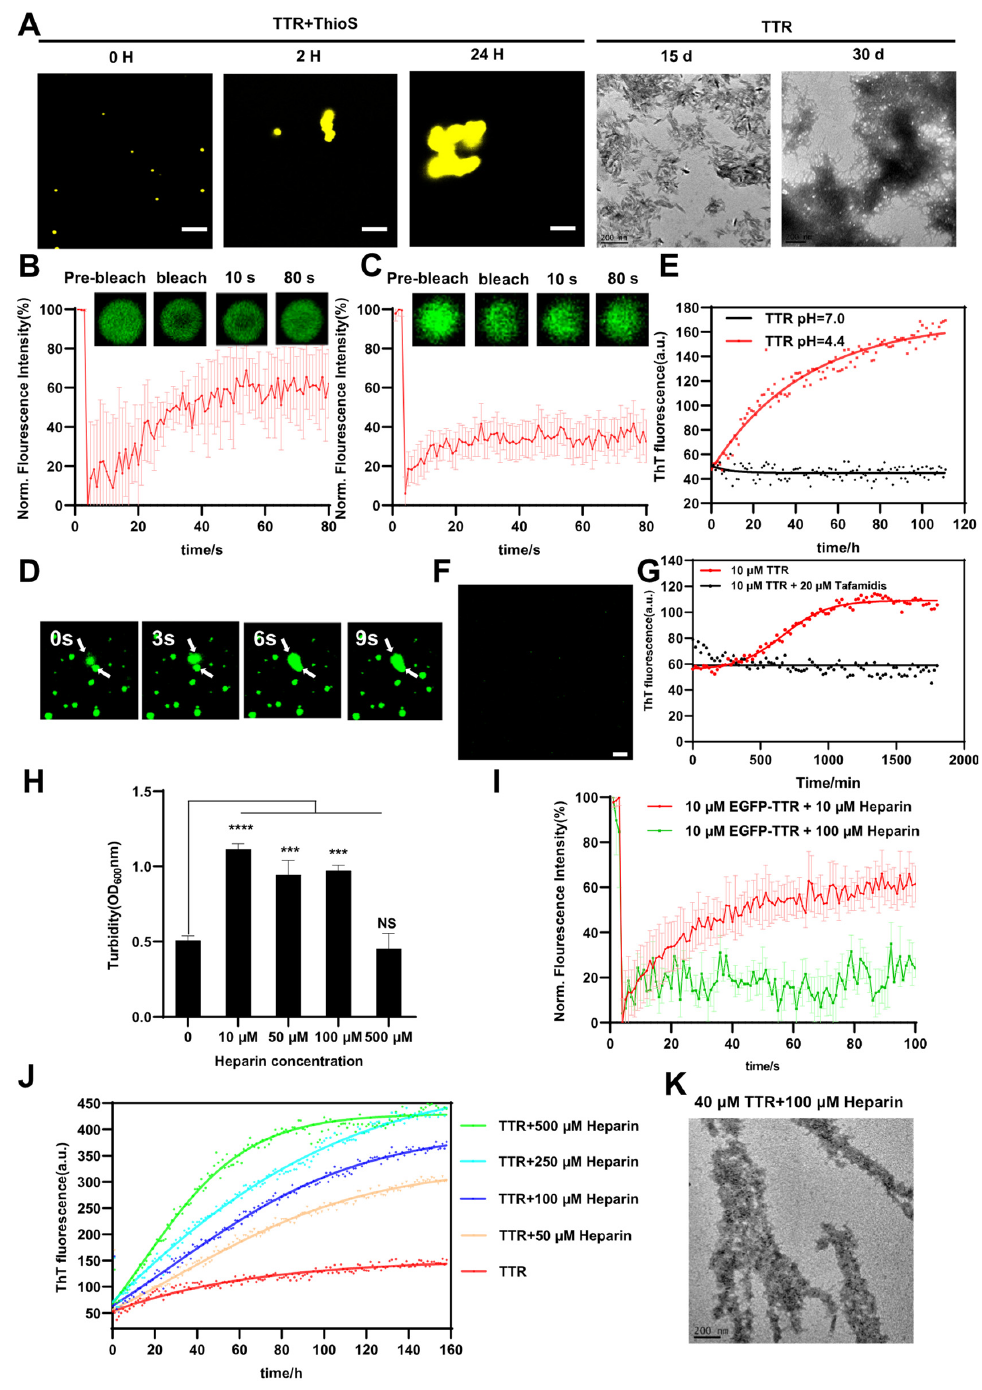
Figure 2. TTR droplets mature and age into fibrillar aggregates, and heparin promotes this process. ( A ) Time-dependent changes of TTR liquid droplets analyzed by ThT staining and TEM imaging. 10 μ M TTR were incubated at pH 4.4, 37 °C. Scale bar, 2.5 μ m. ( B ) FRAP of 10 μ M fresh EGFP-TTR at pH 4.4. Error bars represented SEM (n = 3). ( C ) FRAP of 10 μ M EGFP-TTR incubated 1 h at pH 4.4. Error bars represented SEM (n = 3). ( D ) Time-lapse imaging of droplet fusion. 10 μ M TTR were incubated at pH 4.4. ( E ) The ThT fluorescence intensity traced for 40 μ M TTR at pH 4.4, 37 °C. ( F ) Confocal microscope of 10 μ M EGFP-TTR and 20 μ m tafamidisat at pH 4.4. Scale bar, 5 μ m. ( G ) The ThT fluorescence intensity traced for 10 μ M TTR and 20 μ M tafamidis at pH 4.4, 37 °C. ( H ) Turbidity of 10 μ M EGFP-TTR in the presence of varying heparin concentrations at pH 4.4. Error bars